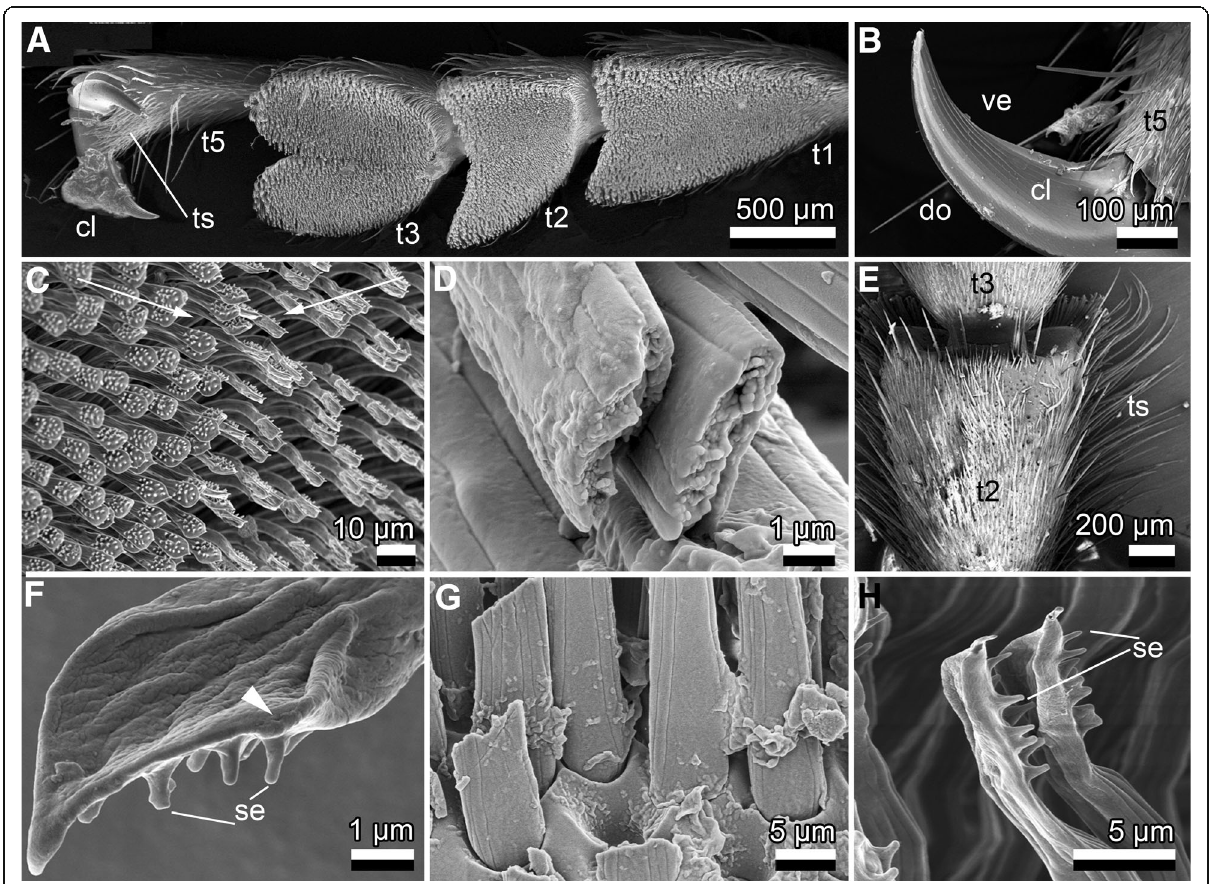
Fig. 2 Cryo-SEM micrographs of tarsal structures of female Monochamus alternatus. a . Ventral view of a female ’ s foretarsus. Note the distinctly bilobed pad in the 3rd tarsomere. b . A single part of the paired claws, equipped with sharp edges ventrally and dorsally (female). c . Terminally spatulate, adhesive setae on the first tarsomere of a female ’ s foreleg. The arrows indicate the opposite, anisotropical orientation of setal terminals, with adhesive surfaces facing each other, according to the bilobed pad of the first tarsomere as mentioned for ( a ). d . Cross section of setae, showing their flattened, ribbon-like shape (female). e . Dorsal view of male ’ s second tarsomere, laterally bearing numerous long tactile setae. f . Ventro-lateral view of the setal terminal, illustrating the tapered tip and spindle-shaped adhesive area surrounded by a ridge (arrow head), and dorsally situated setules (female). g . Broadened, flattened basal shafts of setae (female). h . Lateral details of terminals of spatula-shaped female ’ s tarsal adhesive setae, showing 5 – 10 setules (se) at their dorsal side, suggesting the avoidance of coagulation of the extremely thin (ca. 0.3 μ m) terminals. t1, 1st tarsomere; t2, 2nd tarsomere; t3, 3rd tarsomere; t5, 5th tarsomere; ts, tactile setae; cl, claw; do, dorsal; se, setule; ve, ventral. Note that t4, the 4th tarsomere is hidden and not shown in the